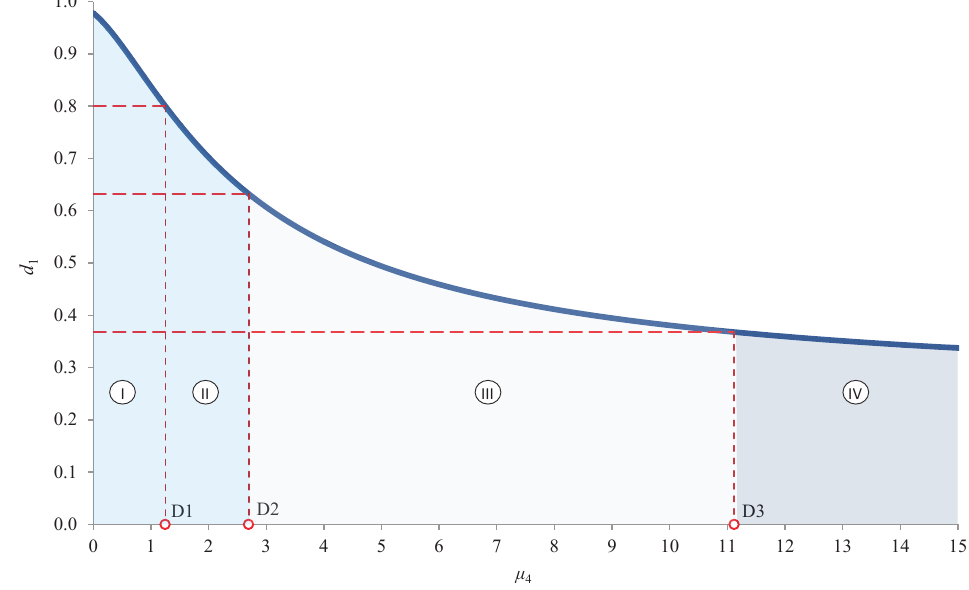
Figure 4 Graphic interpretation of Harrington’s individual desirability function given